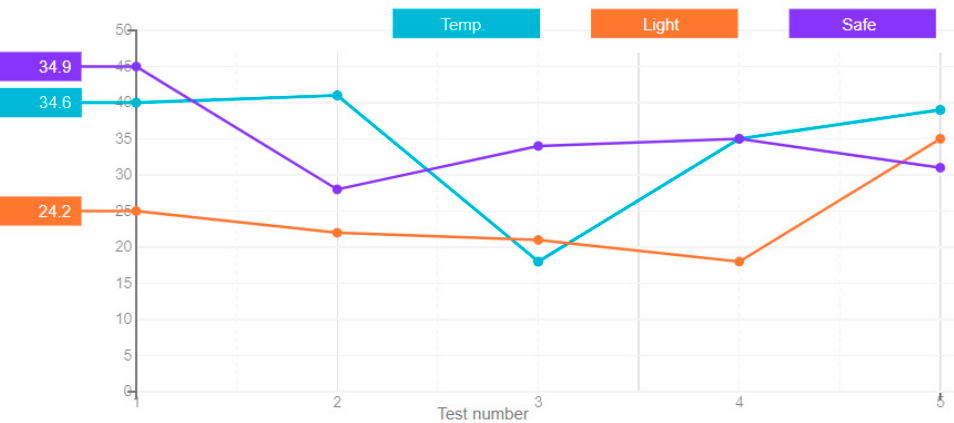
Figure 7. A chart of the gated recurrent units ANN’s error values.